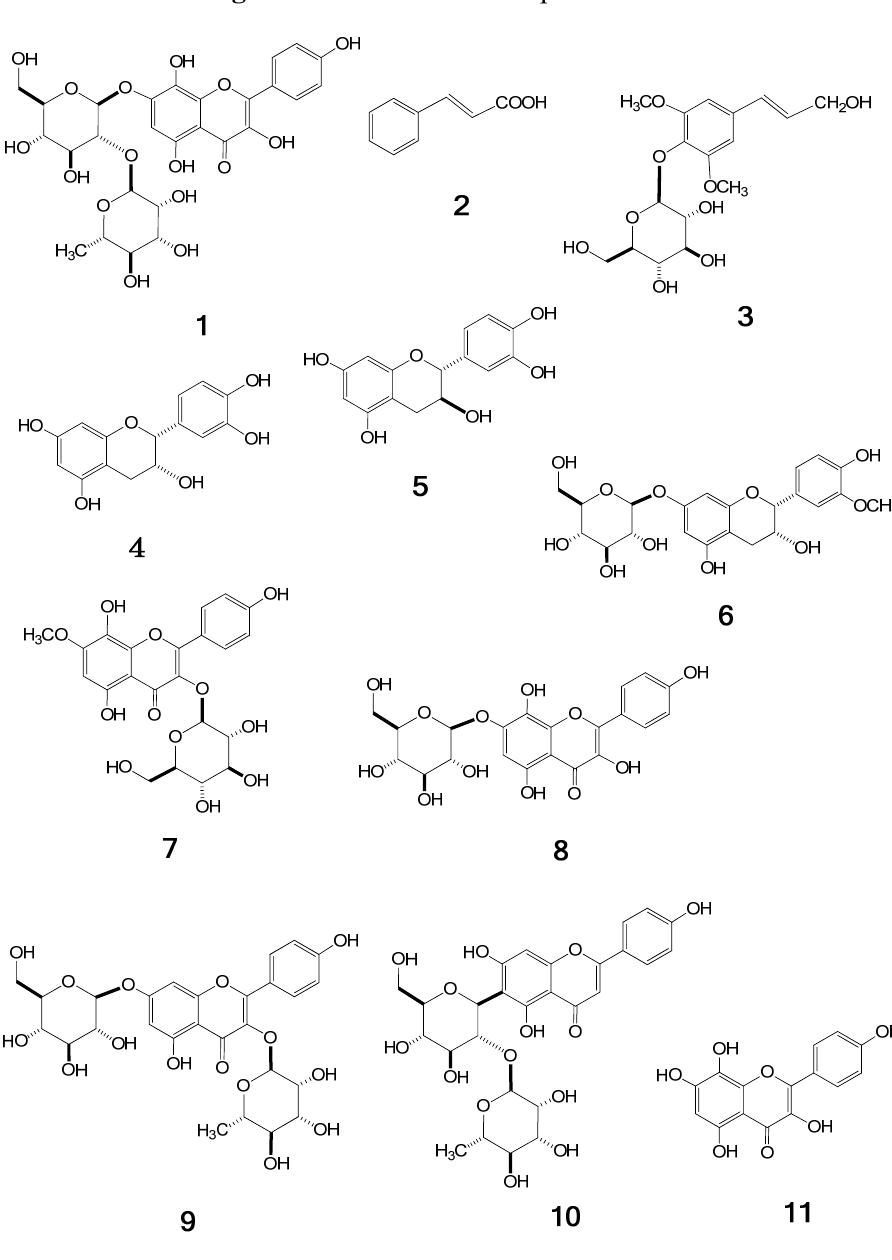
Figure 1. Structures of compounds 1 – 11